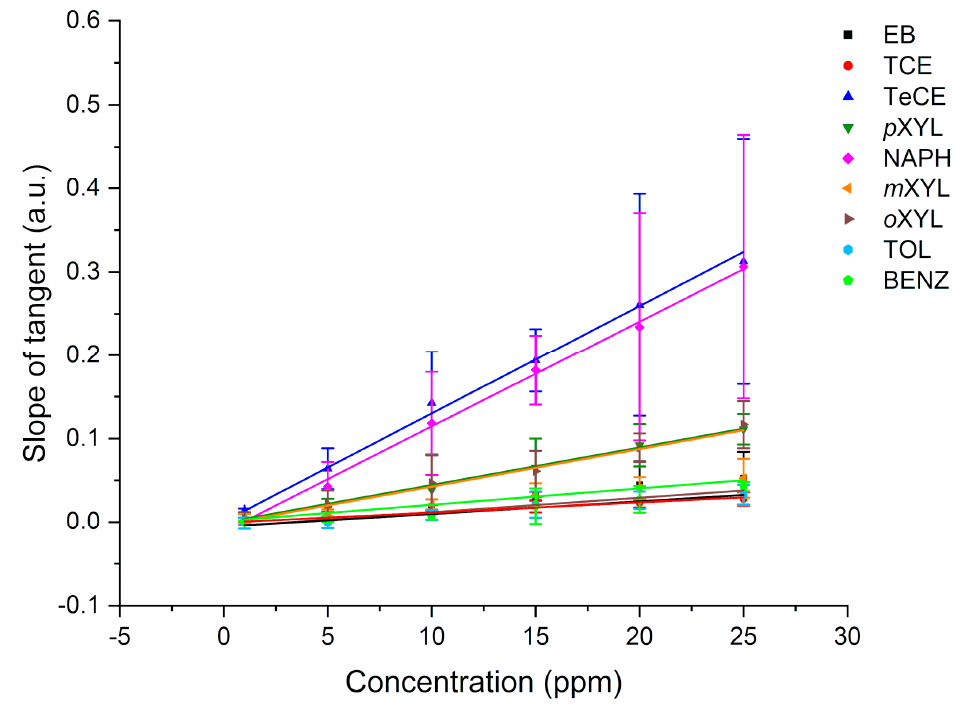
Figure 4. Established calibration functions using the equilibrium method. Black: EB, red: TCE, dark blue: TeCE, dark green: p XYL, pink: NAPH, orange: m XYL, brown: o XYL, light blue: TOL, and light green: BENZ. The concentrations 1, 5, 10, 15, 20, and 25 ppm were used. In the case of TOL, 5 to 30 ppm was measured. Each data point represents 10 repetitive measurements after achieving steady-state conditions.